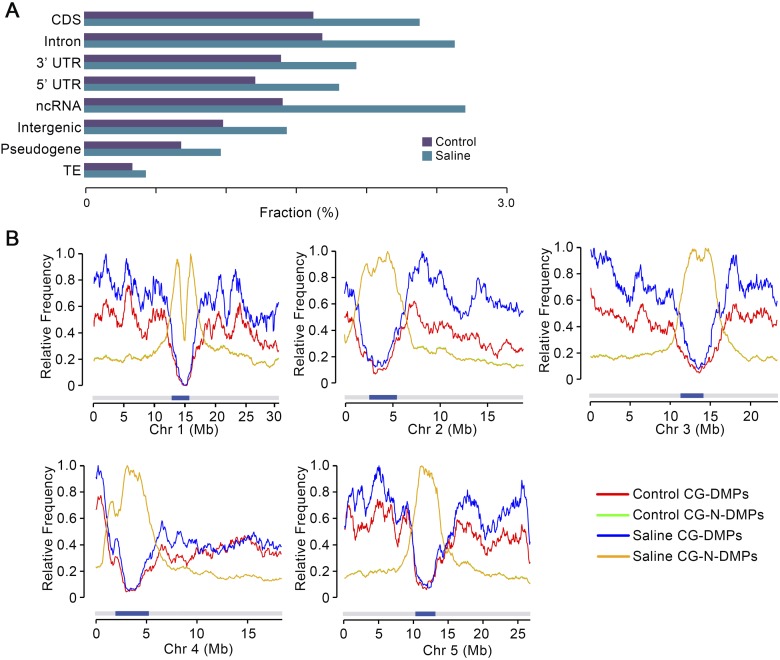
Genome-wide distribution of CG-DMPs in saline soil and control MA lineages. (A) Distribution of CG-DMPs in genomic regional categories as determined by genome sequence annotation. (CDS) Coding DNA sequence; (UTR) untranslated region; (ncRNA) noncoding RNA; (TE) transposable element, expressed as fraction of total methylated GC sites in all saline soil and control G10 samples. (B) Distribution along individual chromosomes (Chr 1, Chr 2, etc.) of CG-DMPs and CG-N-DMPs (see text for definition of CG-N-DMPs). Data from G10 saline soil and control samples were normalized to the highest value for each chromosome and class (CG-DMPs or CG-N-DMPs). Dark blue bars indicate centromeres. Because Control and Saline CG-N-DMPs track very closely, the latter trace substantially obscures the former.